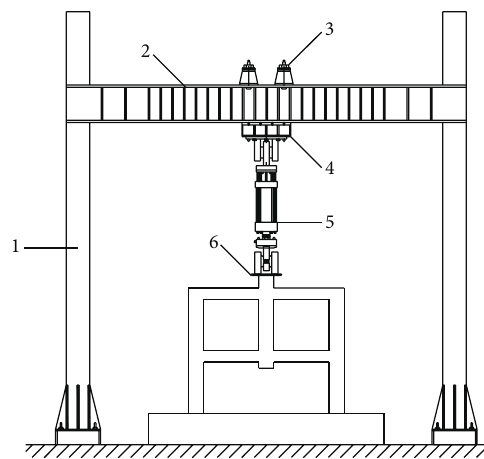
Figure 5: Schematic diagram of loading equipment. (Note: 1. column; 2. load-carrying beam; 3. girder; 4. box girder; 5. servo- hydraulic actuator; 6. steel